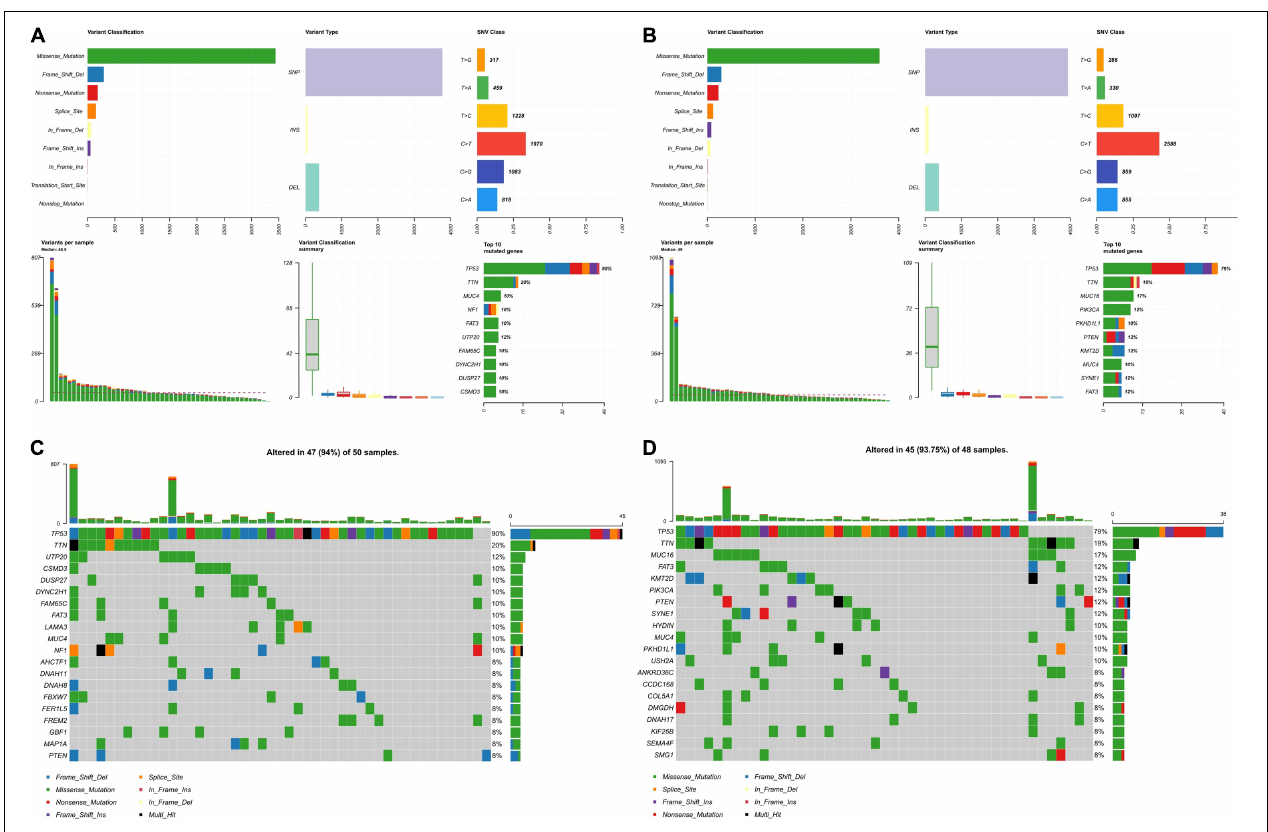
FIGURE 8 | Landscape of mutation profiles in the low-and high-risk groups. (A) Overview of mutation types in the high-risk group. (B) Overview of mutation types in the low-risk group. (C) Waterfall Plot of the top 20 genes with the most mutations in the high-risk group. (D) Waterfall Plot of the top 20 genes with the most mutations in the low-risk